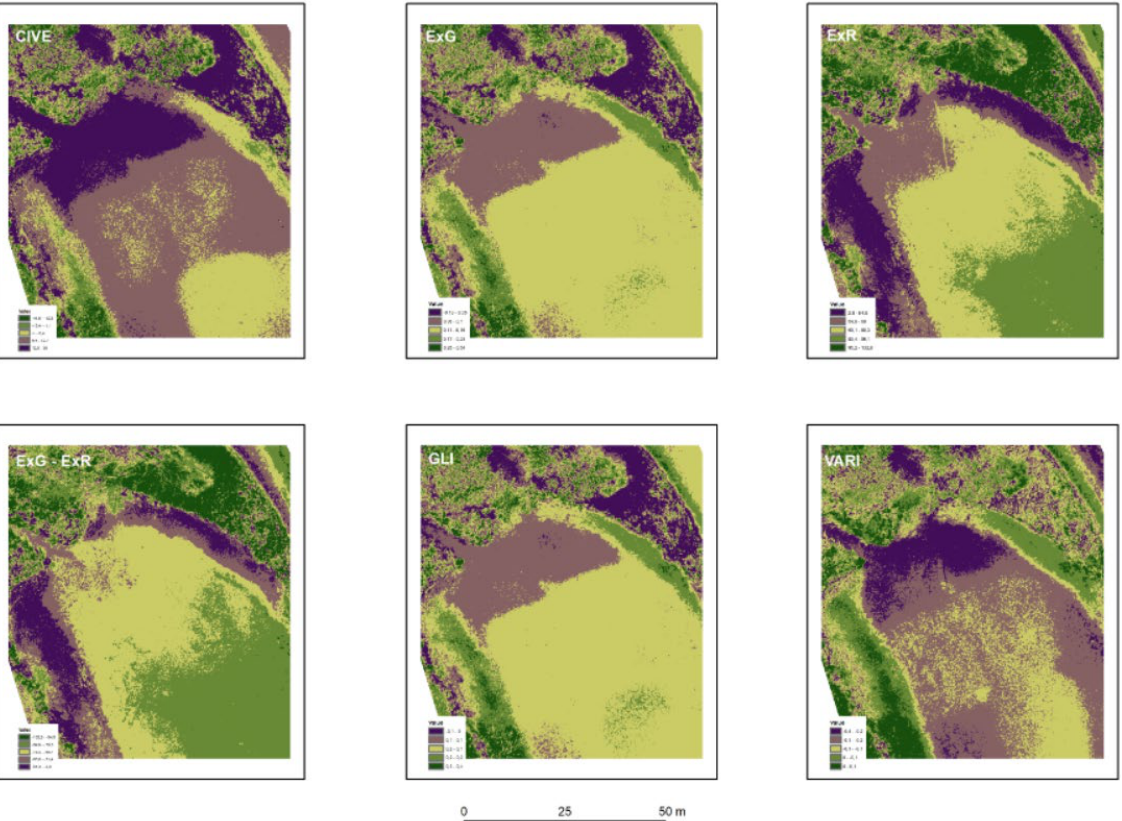
Figure 5. Spectral indices for the area on April 20, 2018, after low pass